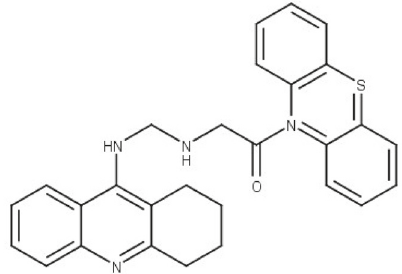
FIGURE 17 - Tacrine-phenothiazine derivative with multitarget action against the enzymes AChE, tau, amyloid-A4 (ABPP), GSK-3α, GSK-3β, MAO-B, and PS-1.